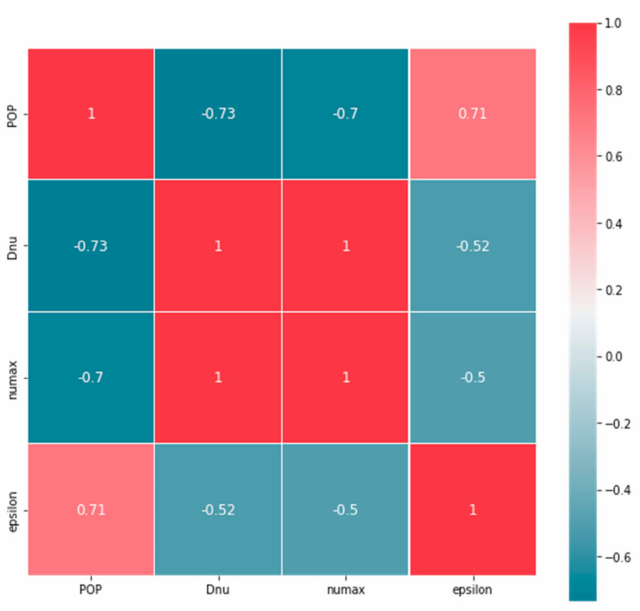
Figure 7. The asteroseismology dataset features correlation